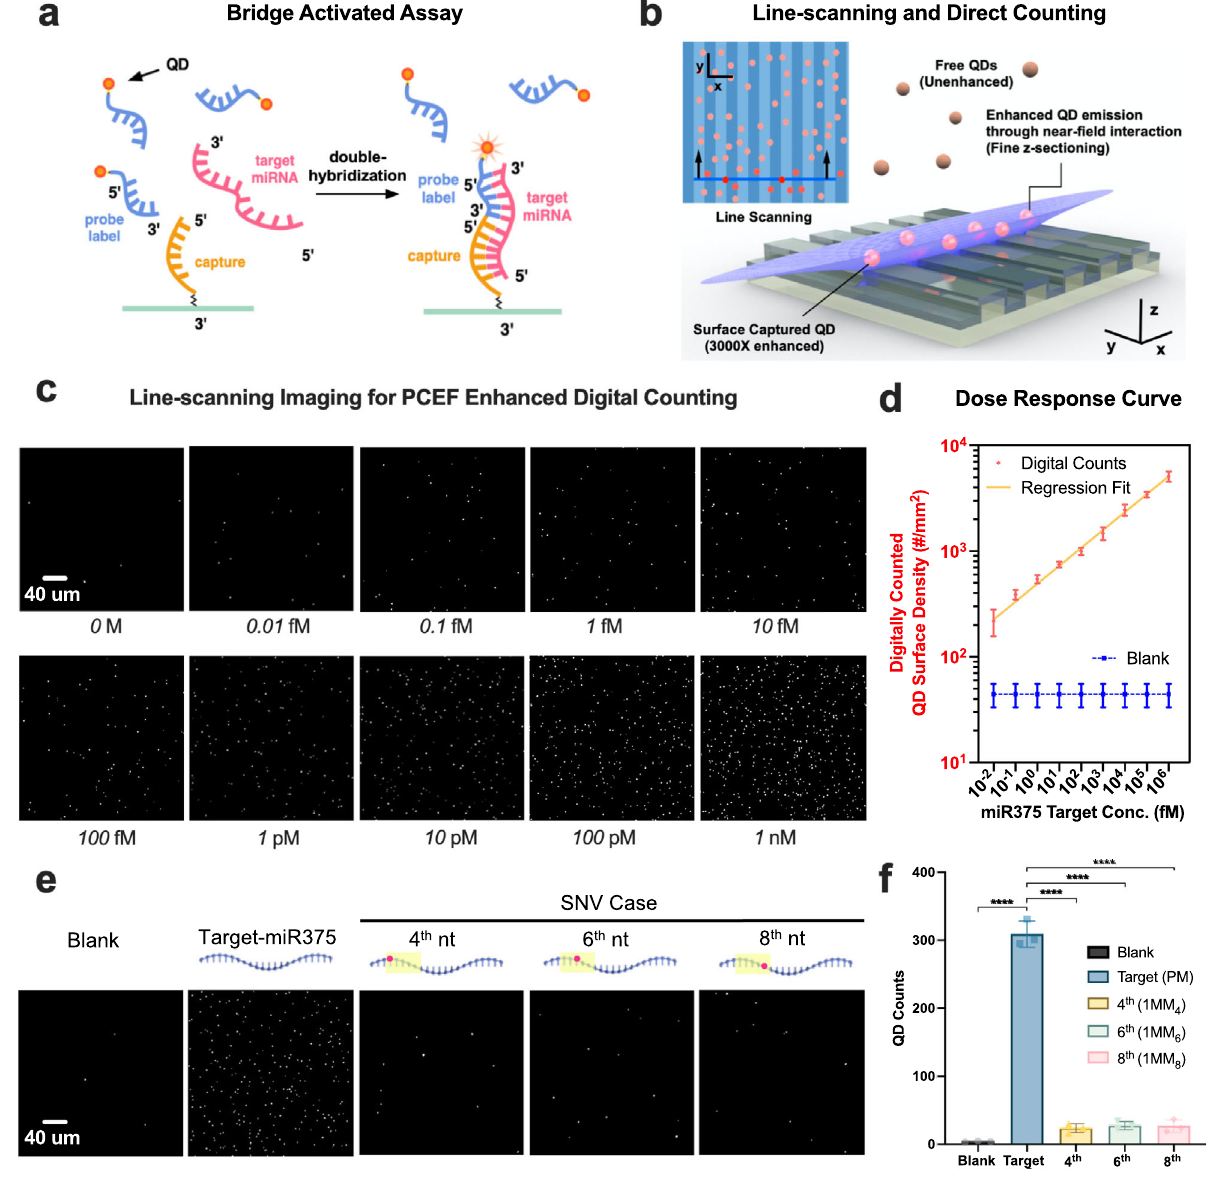
Fig.4|CountingresultofmiR375bridgeassayinhumanserum.a Inthebridge- activatedassay process, QD-tagswillbe pulleddown to thePCsurface whentarget miRNAsbridgetheformationofasurface-boundcomplex. b Illustrationoftheline- scanning process that counts the number of PC-attached QDs. c Line-scanning Imaging: for PCEF enhanced digital counting in human serum. Target concentra- tion: 10aM to 1nM. FOV: 300 µ m×300 µ m. Scale bar: 40 µ m. Data are averages from more than 9 FOVs, and error bars indicate the standard deviation between three independent replicas. Statistical signi fi cance was tested using one-way ANOVAbetweenthenegativecontrolgroupandalltestinggroupswith P <0.0001; Imaging conditions for the assay on the PC: laser power=1mW, EM-gain=40×; Higher laser power (5mW) and EM-gain (1200×) are needed in order to detect the intensitychangeat1 – 10pMonglasswhileavoiding signalsaturationat1nM;Same